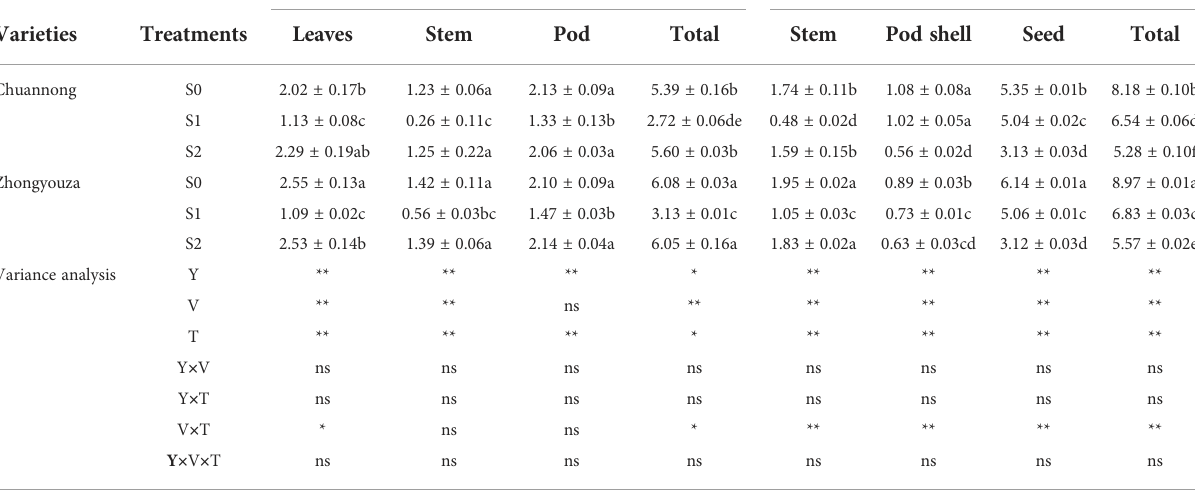
TABLE 1 Effect of shading on accumulation and distribution of nitrogen in rapeseed. N accumulation at pod development (g plant ˗ 1 ) N distribution at maturity (g plant ˗ 1 ) Varieties